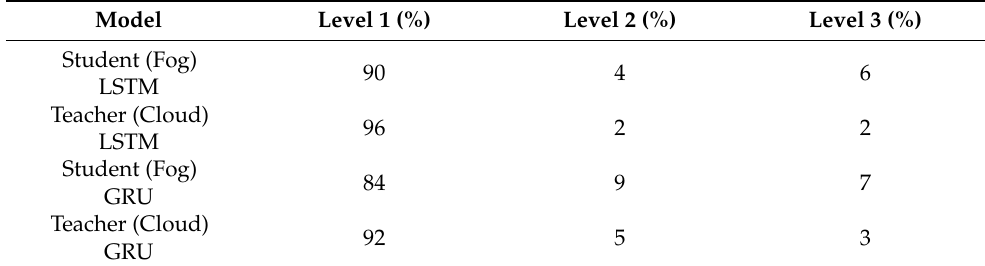
Table 4. Alarm-level test result percentages for the CWRU dataset.